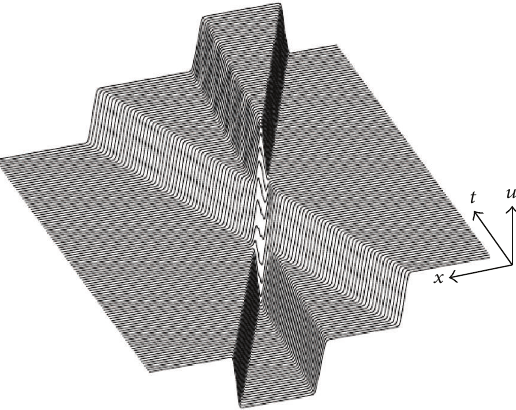
Figure 3: Evolution of the kink-triplet, 𝑉 1 > 0 , 𝑉 2 < 0 , 𝑉 3 < 0 .